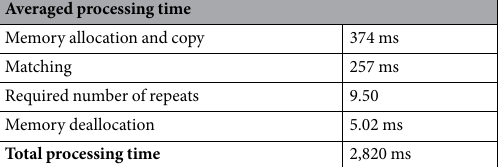
Table 1. Averaged GPU processing time to estimate surface.